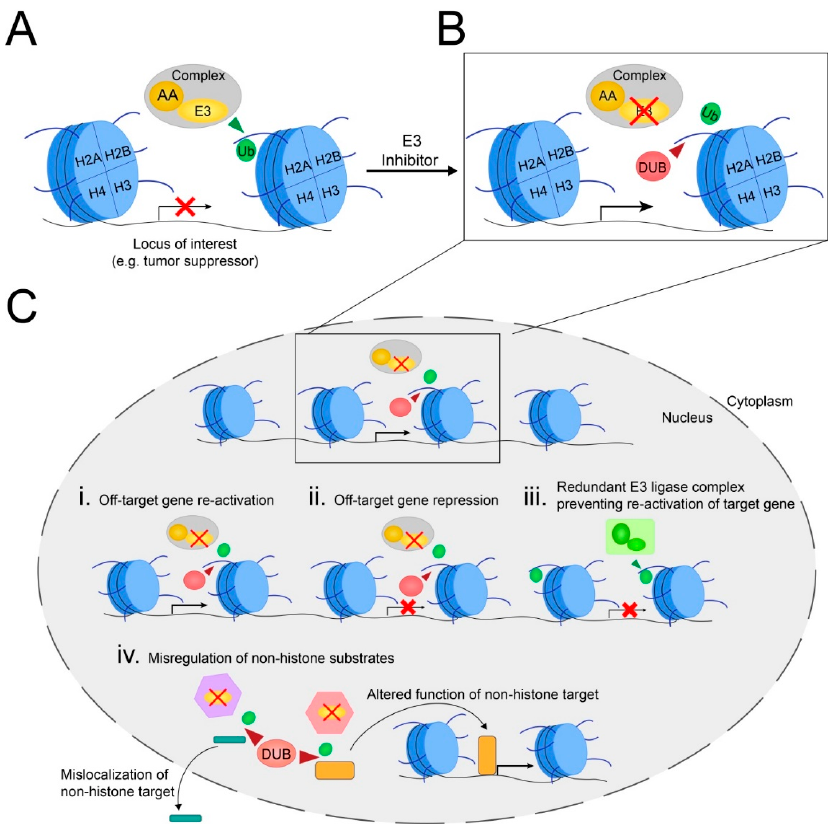
Figure 2. Schematic presenting putative impacts associated with targeting the histone ubiquitination